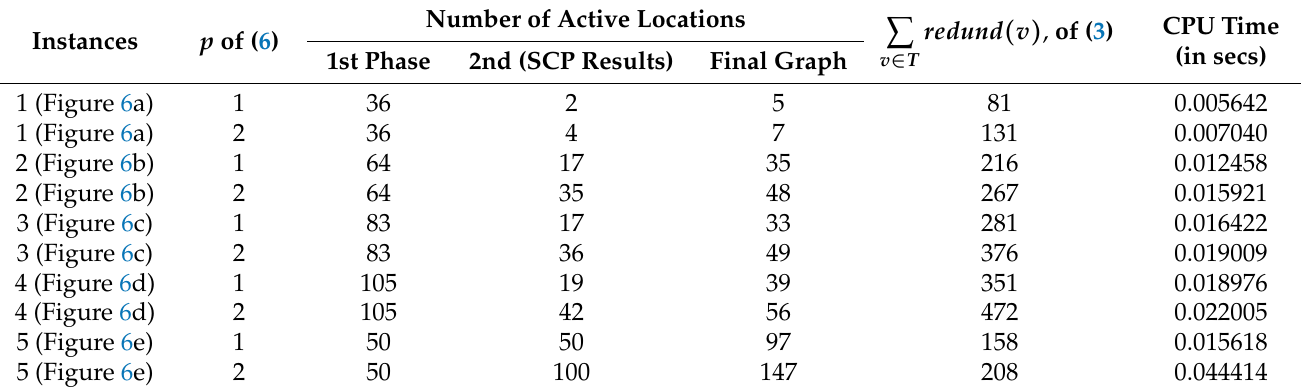
Table 3. Results for the input instances with 2 values of required minimum redundancy parameter p